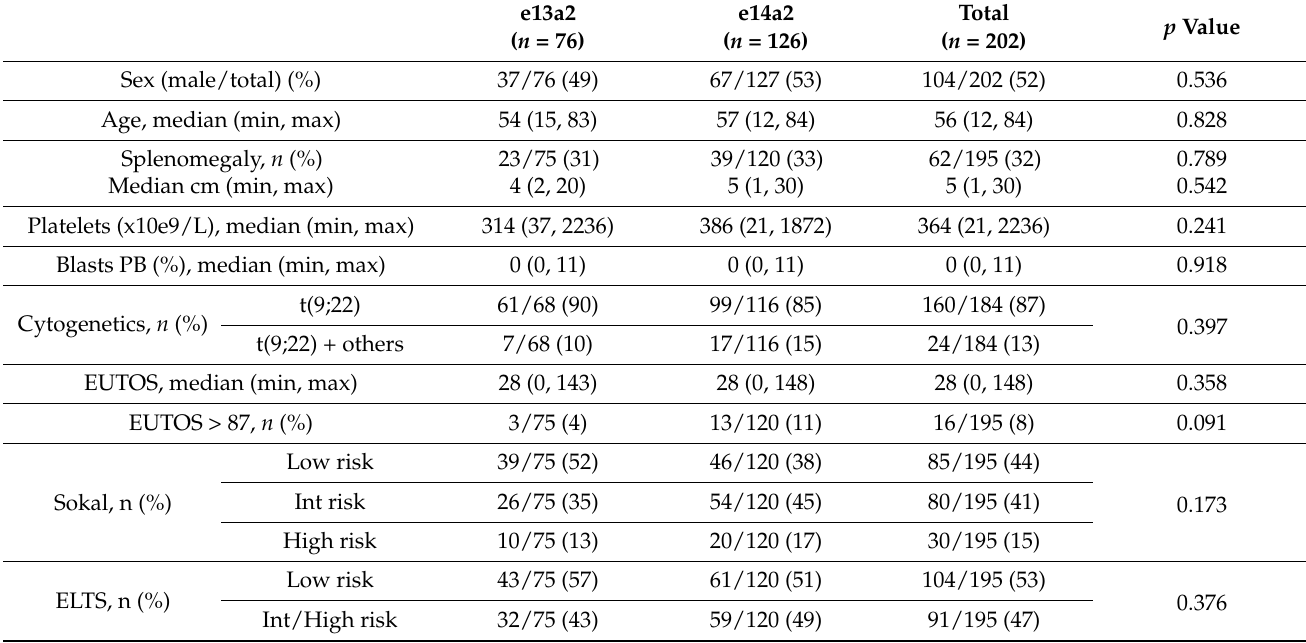
Table 1. Demographic and baseline clinical characteristics of the study series.